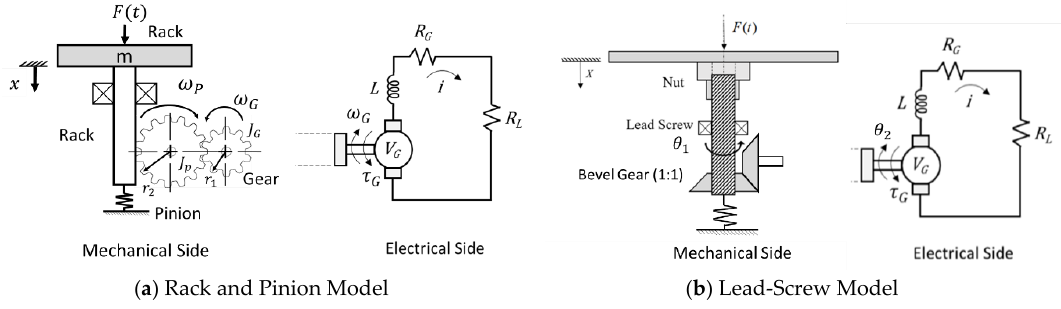
Figure 3. Physical models: ( a ) Rack and Pinion Model; ( b ) Lead-Screw Model.